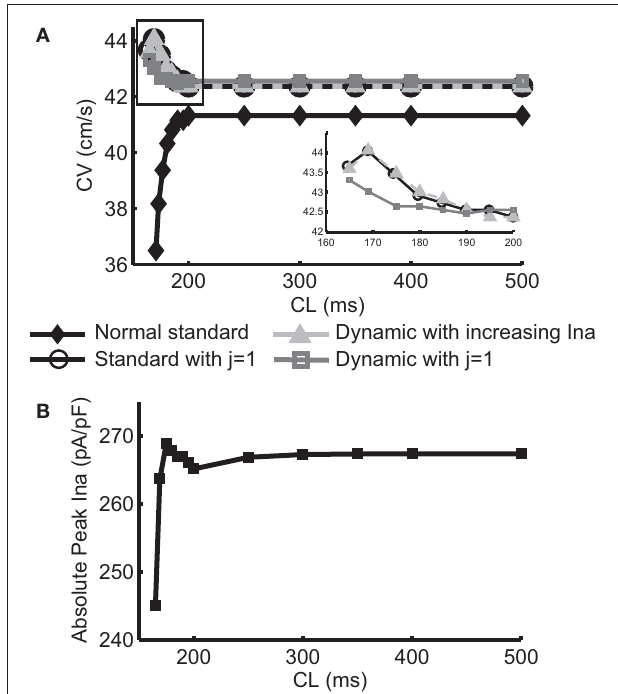
FIGURE 1 | (A) Normal CV restitution obtained using the standard S1S2 protocol overlaid with negative CV restitutions obtained using three different approaches. The inset shows a “zoomed in” view of the three negative CV restitutions at CL ≤ 200ms. (B) Trace of peak I Na (absolute values) at each CL used in protocol